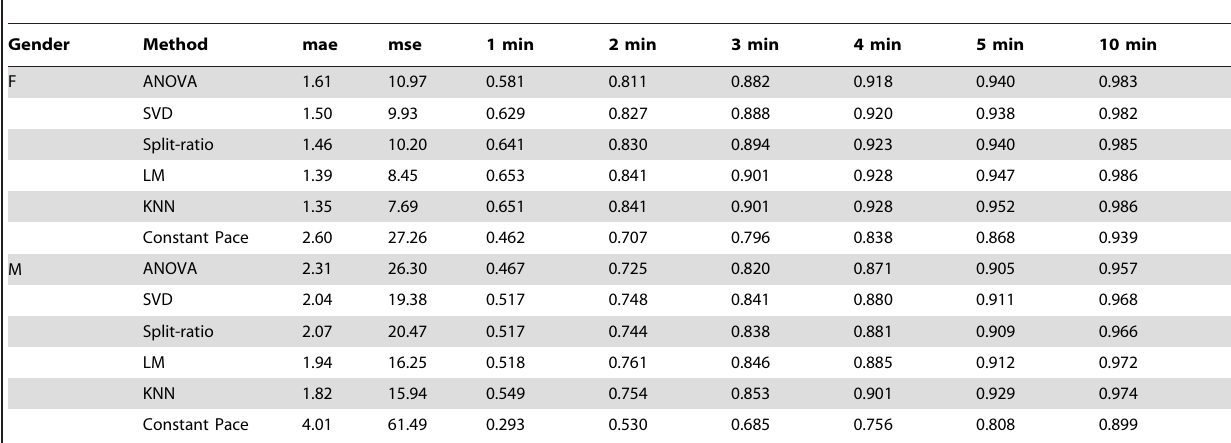
Table 3. Results by